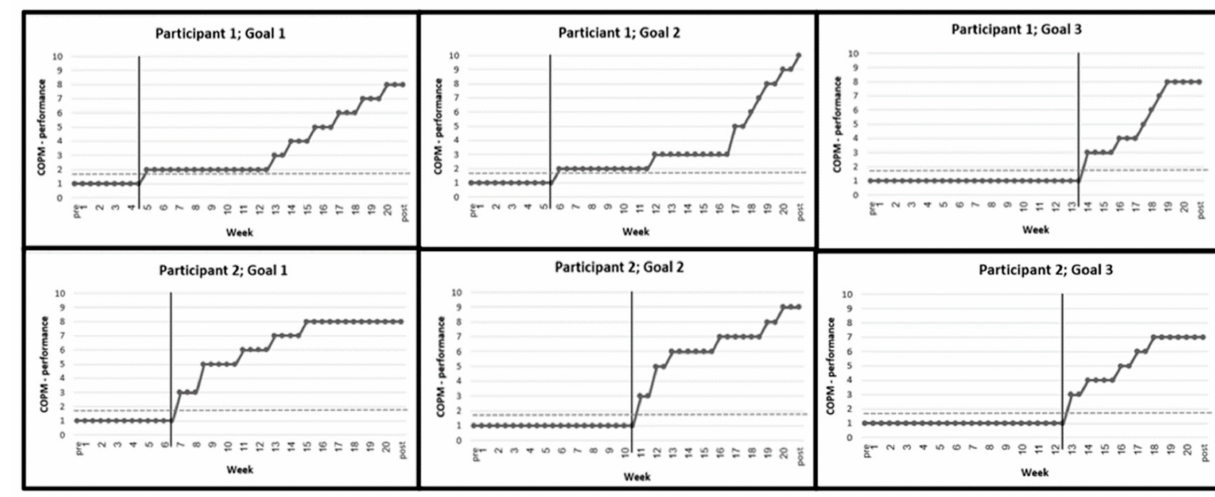
Figure 1. Changes in the Canadian Occupational Performance Measure (COPM): performance scores during baseline (week 1–4), intervention (week 5–16), and follow-up (17–20) phases. Notes: Participant 1: Goal 1: Buying sweets at the supermarket for the nephews; Goal 2: Preparing food for family members; Goal 3: Participation in prayers in the synagogue. Participant 2: Goal 1: Buying clothes with the sister; Goal 2: Preparing a dish for a family meal according to a recipe; Goal 3: Maintaining social interaction in meetings with